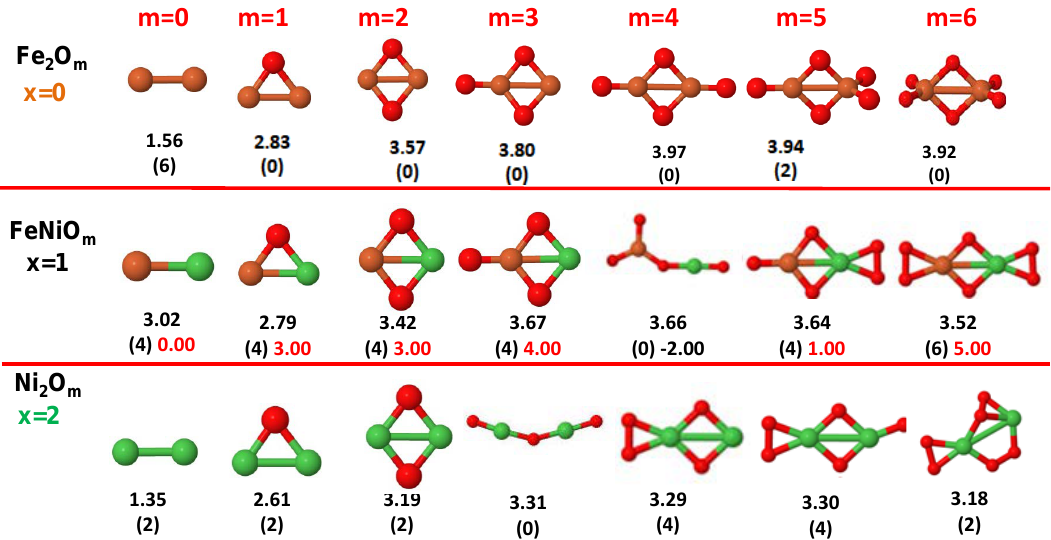
Figure 3. Putative global minimum structures of Fe 2 − x Ni x O m , x = 0–2, m = 1–6. Numbers below structures are the binding energy per atom (in eV), numbers in parentheses are the magnetic moment (in µ B ) and the third number (when present) is the excess magnetic moment (in µ B ) defined in Equation (2). Fe atoms in brown color, Ni atoms in green and oxygen atoms in red.